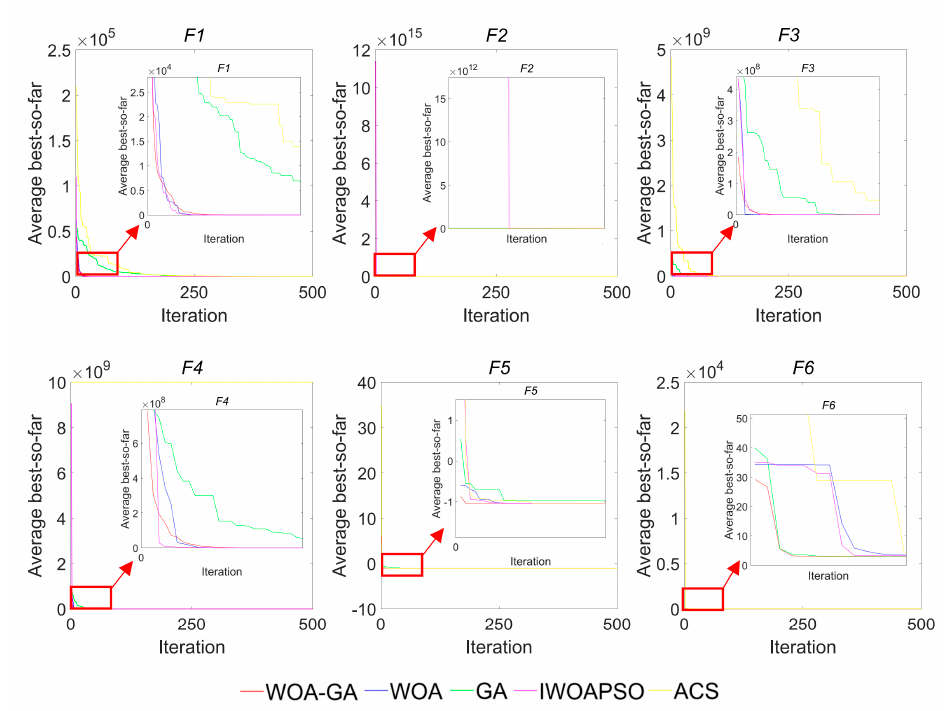
Figure 2. Convergence curves from WOA-GA, WOA, GA, IWOA-PSO and ACS.